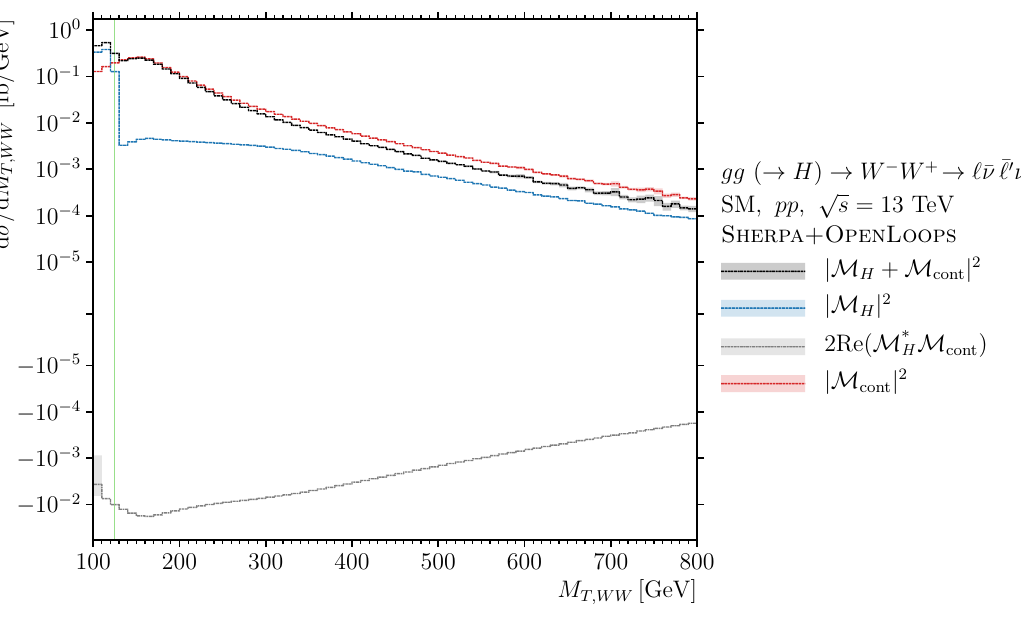
Figure 27 . M T,WW distributions for the process gg ( → H ) → W − W including its interference with the background in pp collisions at √ s = 13 TeV. Other details as in figure